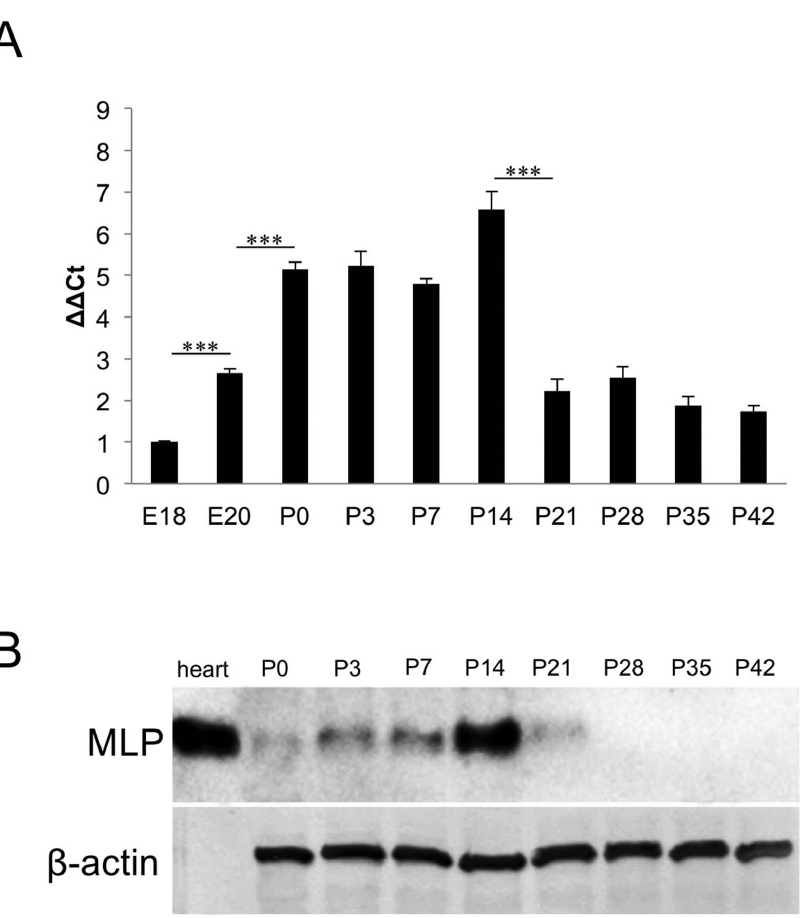
Figure 1. Transient MLP-expression in postnatal retinae. A : Quantitative real-time PCR of embryonic and postnatal rat retinae. Relative MLP expression is shown as fold change of the respective value at E18. MLP expression was increased at E20 compared to E18 and further increased significantly after birth. Highest MLP-expression was detected at P14 (a fold change of 6.6). MLP expression levels sharply decreased between P14 and P21 and reached a plateau afterwards. Comparison of relative expression: ***P # 0.05. B : Western Blot analysis of MLP protein in postnatal retinae (P0– P42). MLP levels increased slightly between P0 and P7 and peaked at P14. MLP levels were markedly decreased at P21 and were below detection in retinal lysates of P28 and older animals. MLP in heart muscle lysate served as positive control and b -actin as loading